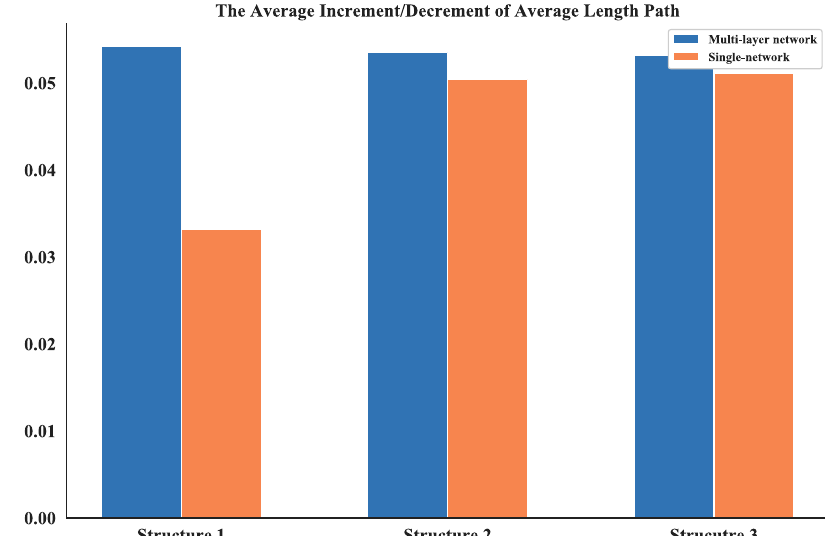
Figure 24. The average increment/decrement of average length path.